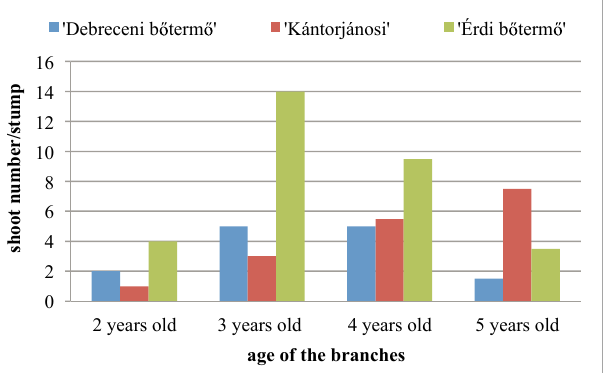
Figure 1. Effect of the partial rejuvenation on the regeneration of the crown parts of different ages (Debrecen – Pallag, 2005).